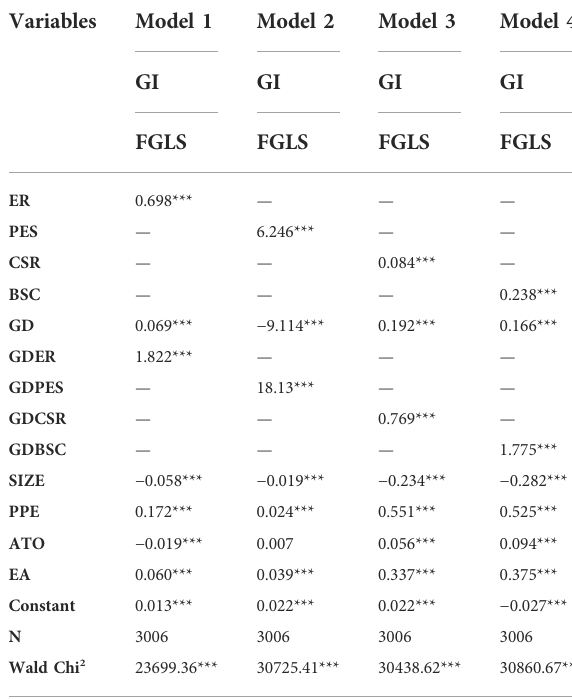
TABLE 9 Robustness of moderating role of